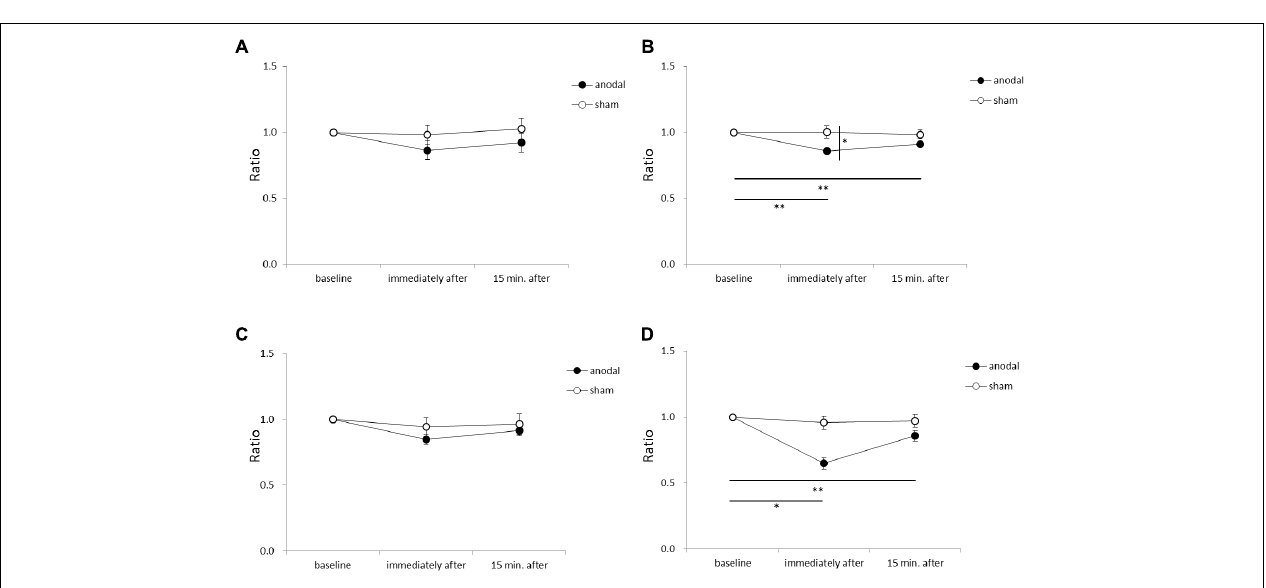
FIGURE 5 | Serial changes in root mean square (RMS) area, sway path length, medio-lateral (ML) mean velocity, and antero-posterior (AP) mean velocity before, immediately after, and 15 min after anodal or sham tDCS over the SMA. (A) Normalized RMS area values. (B) Normalized sway path length values. (C) Normalized ML mean velocity values. (D) Normalized AP mean velocity values. All data reflect the mean ± standard error of the mean. ∗ p < 0.05, ∗∗ p <